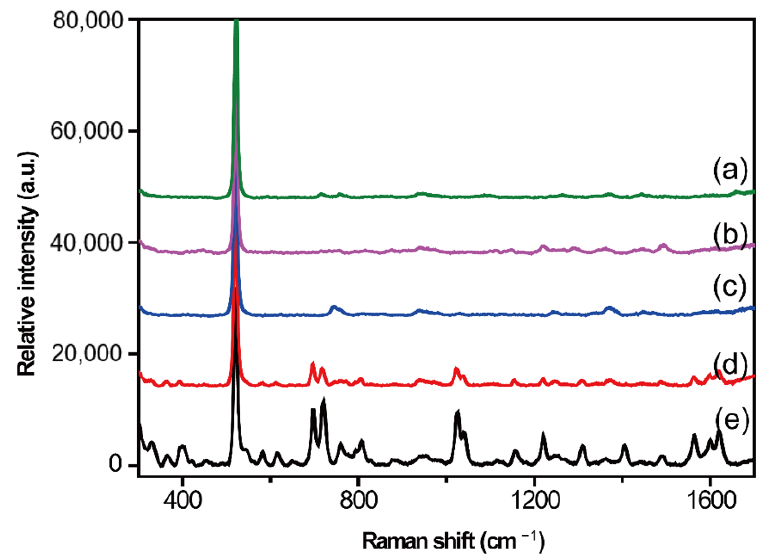
Figure 3. SERS spectra based on the liquid–liquid extraction method. Blank SERS spectrum of the supernatant obtained from blank serum after extraction with ethyl acetate ( a ) and chloroform ( c ). SERS spectra of the simulated sample supernatant after extraction with ethyl acetate ( b ) and chloroform ( d ). SERS spectrum of CBZ standard solution ( e ).